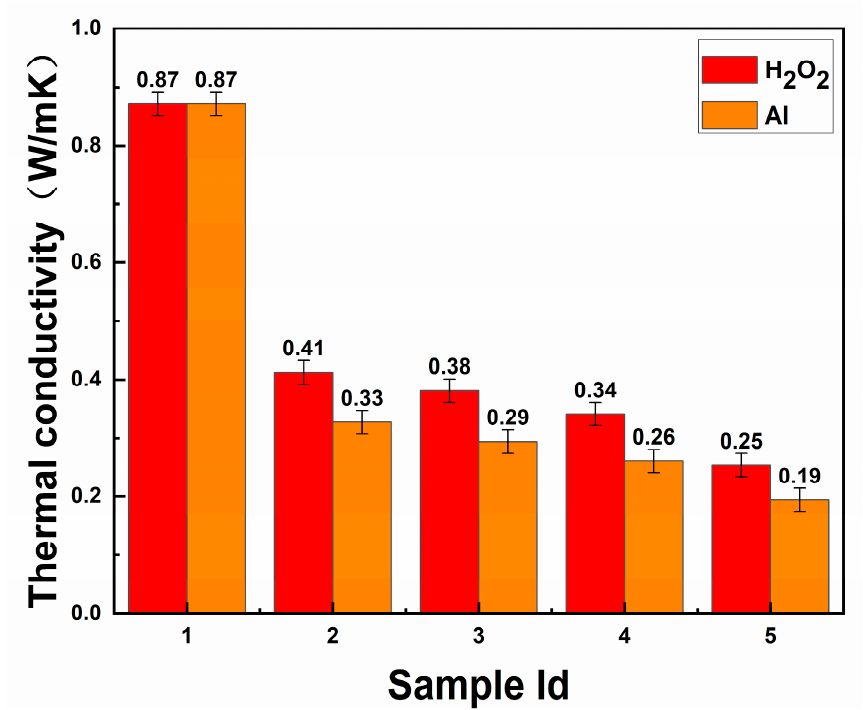
Figure 9. Thermal conductivity of HMNS-FA-phosphate-based porous geopolymers.